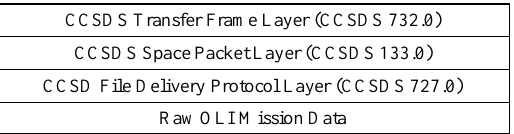
Figure 2. Landsat 8 data downlink protocol stack (USGS, 2010)